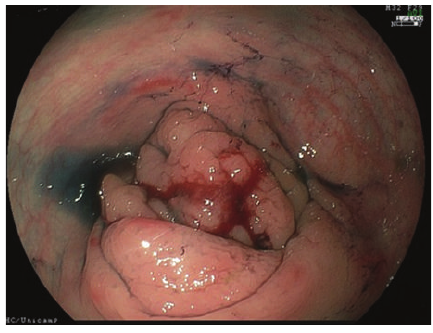
Figure 3: Caf´e au lait macules in the anterior abdominal skin. Figure 4: Polypoid-ulcerated mass in ascending